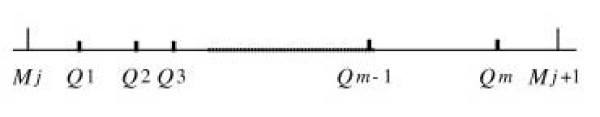
The positions of markers and QTL and their sequence ranged on a certain marker interval.